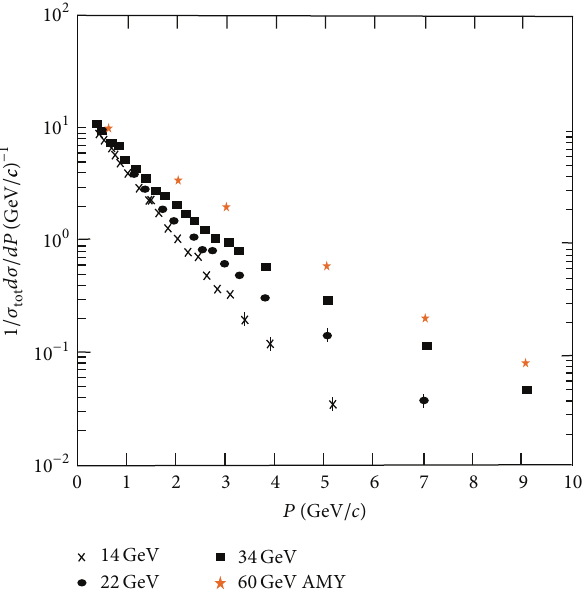
Figure 5: Normalized differential cross section as a function of the momentum of the charged particles for different center of mass energies